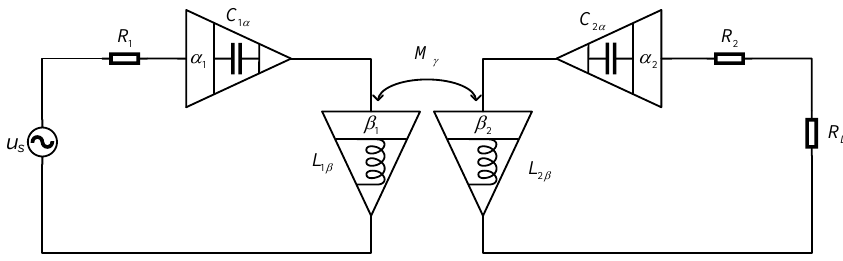
Figure 1. Simplified schematic of the fractional-order wireless power transmission (WPT) system.